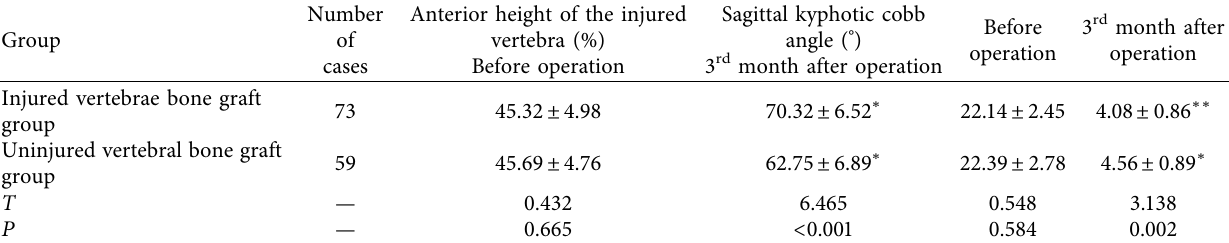
Table 4: Comparison of the recovery level of the injured vertebra between the two groups of patients ( X ± S ).